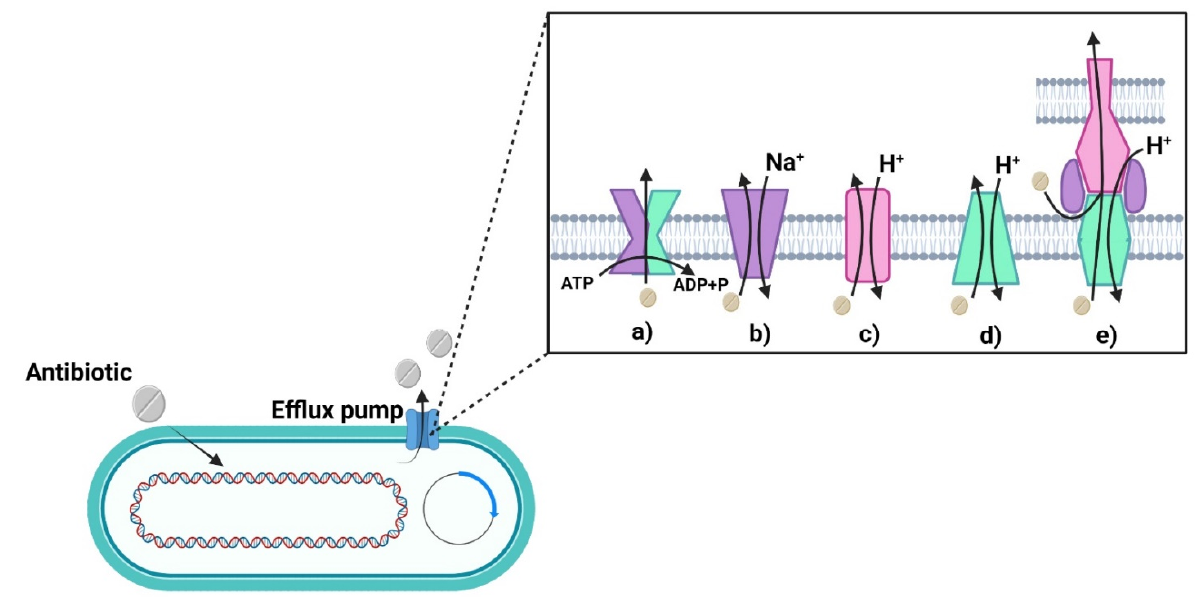
Figure 2. Efflux pump families: ( a ) ABC, ( b ) MATE, ( c ) SMR, ( d ) MFS, ( e ) RND. Created with BioRender.com (accessed on 17 November 2021).